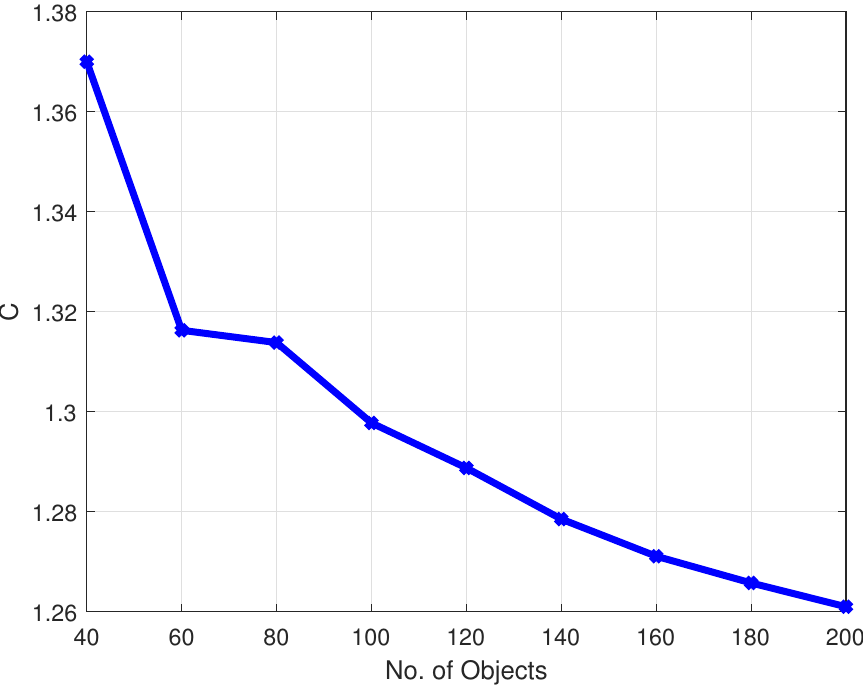
Figure 11. Task planning cost ratio C w.r.t. the number of objects in the dynamic planning scenario Figure 11. Task-planning cost ratio C regarding number of objects in dynamic-planning scenario with r = 5. There are 20 satellites with 5 clusters. The objects are decomposed into 12 clusters. with r = 5. There were 20 satellites with 5 clusters. Objects were decomposed into 12